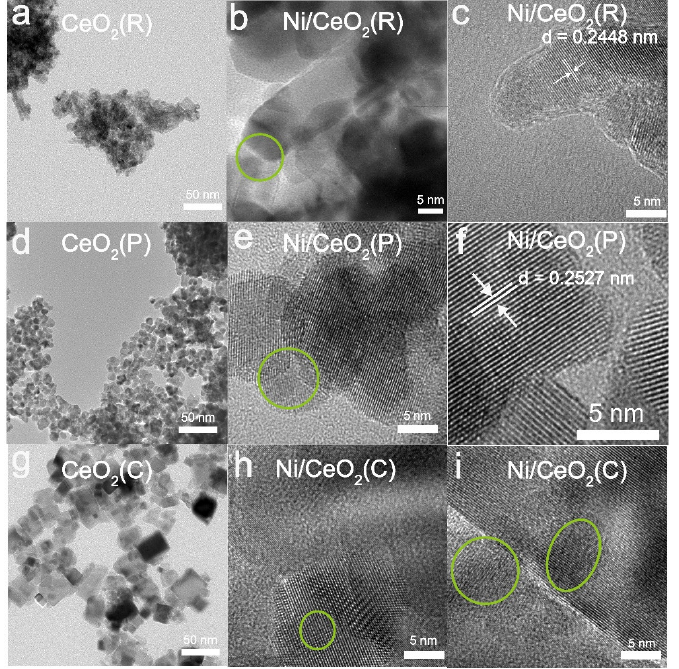
Figure 4. Typical TEM images of standalone ( a ) CeO 2 (R), ( d ) CeO 2 (P), and ( g ) CeO 2 (C) supports and high-resolution TEM images of three catalysts: ( b , c ) Ni/CeO 2 (R), ( e , f ) Ni/CeO 2 (P), and ( h , i ) Ni/CeO 2 (C). Green circles indicate the plausible position of metallic Ni on catalytic materials (d rep- resents the (100) crystal plane of CeO 2 ).